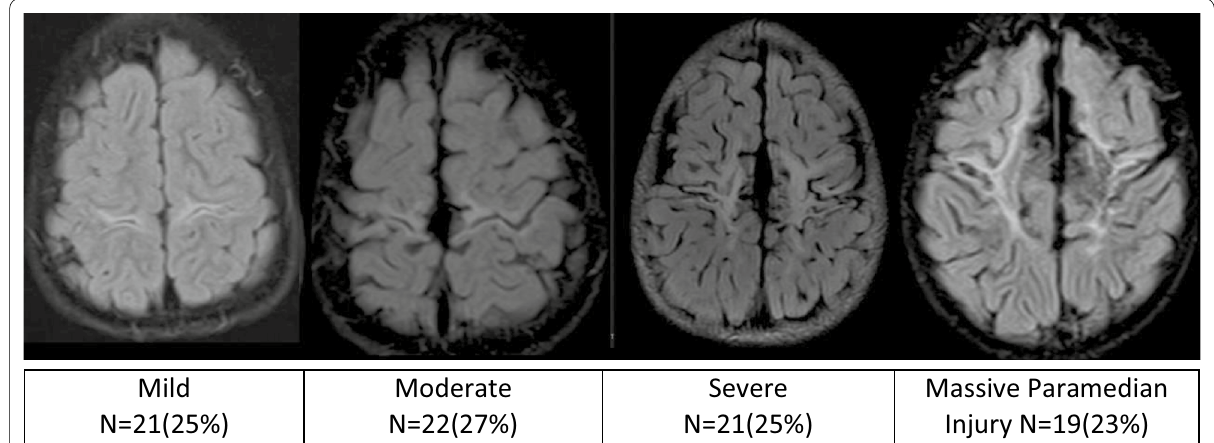
Fig. 9 The proposed classification of parasagittal perirolandic central type